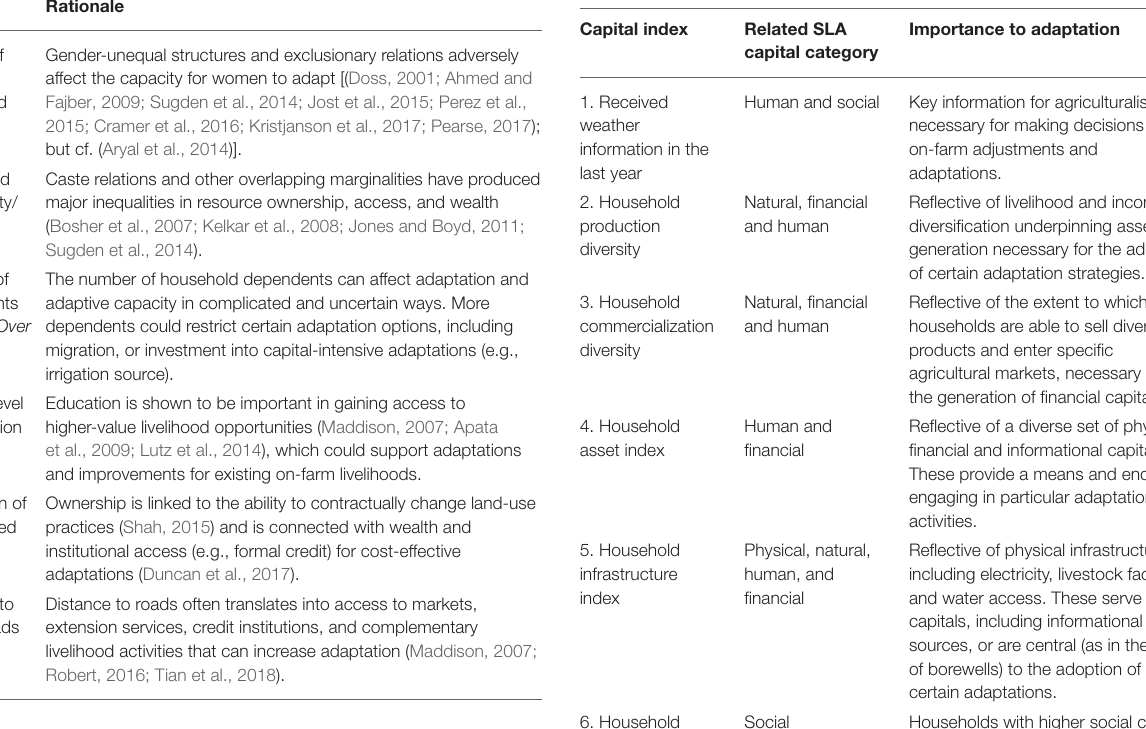
TABLE 2 | Theoretical specification of independent variables. TABLE 3 | Description of the six capital data-driven indices and evidence of their relationships or associations with